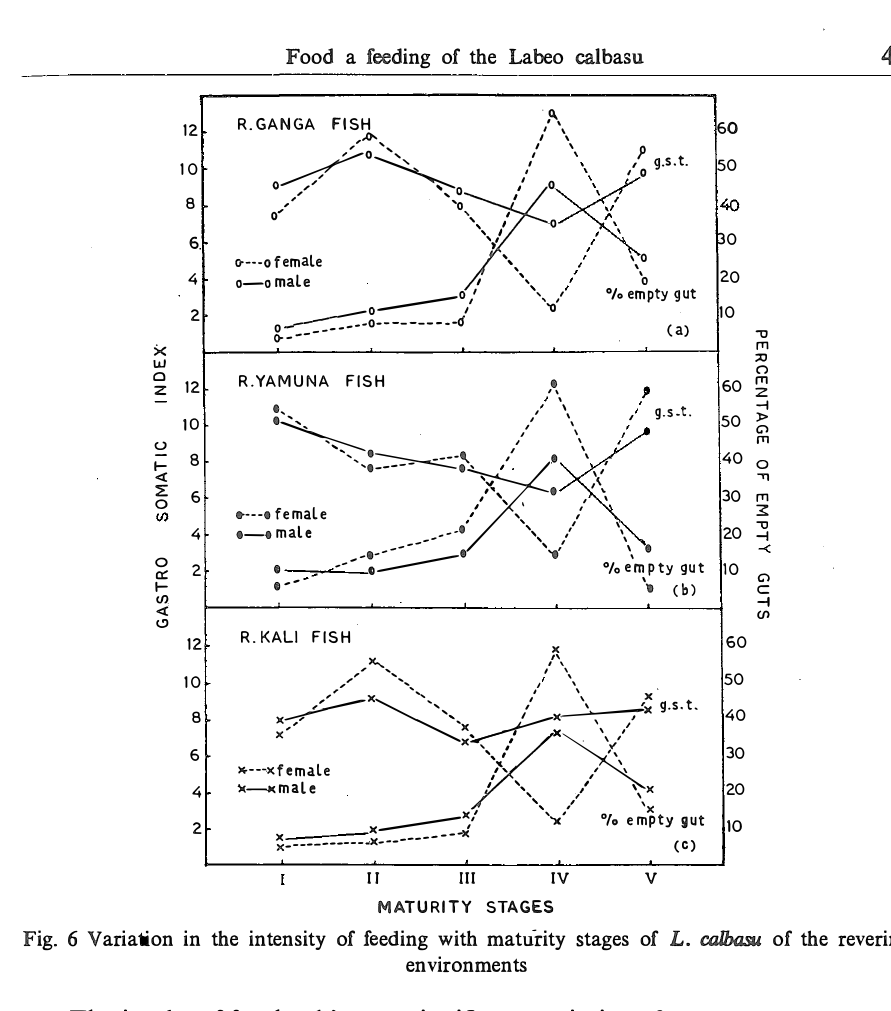
Fig. 6 Variation in the intensity of feeding with maturity stages of L. calbasu of the reverine